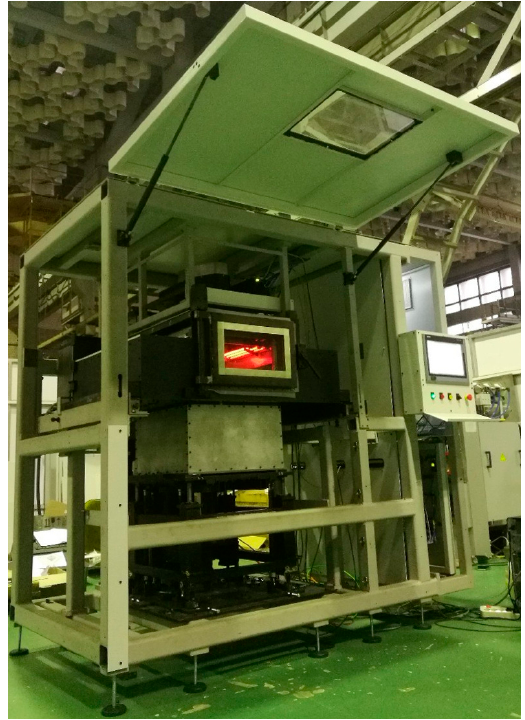
Figure 10. The created installation with the removed protective covers and nodes for access to points 11–22 from Figure 5 in order to maintain temperature control. 11–22 from Figure 5 in order to maintain temperature